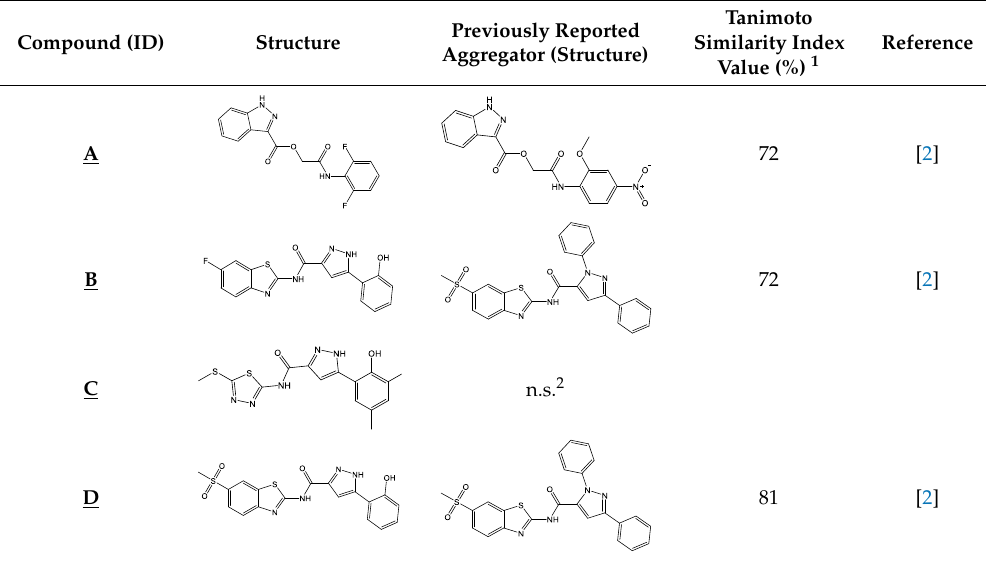
Table 2. Chemical structures of compounds A , B , C and D , chemical structures of some previously reported aggregators, and the corresponding Tanimoto similarity index values (%), obtained using Aggregator Advisor tool [5].